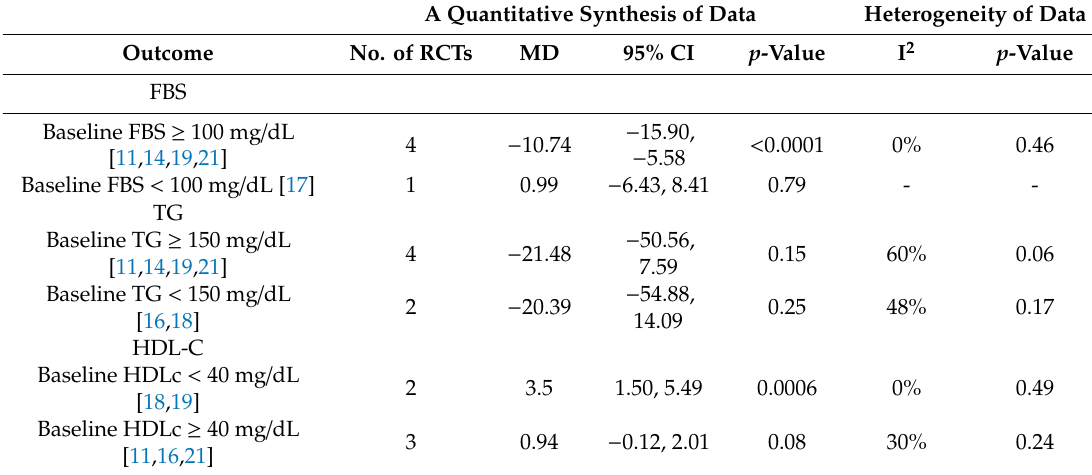
Table 2. Subgroup analysis by baseline status.